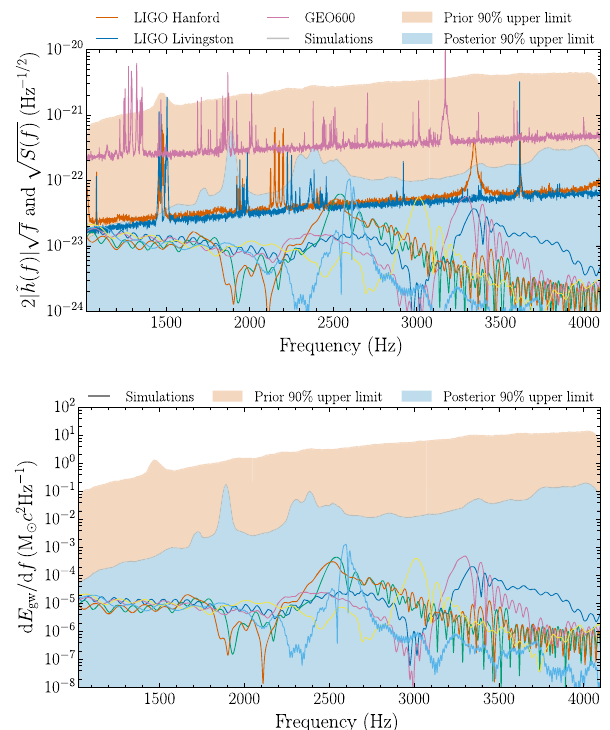
FIG. 13. The 90% credible upper limits on GW strain induced in the Hanford detector (top panel) and radiated energy (bottom panel). Both results are derived from a coherent analysis across the detector network. The noise ASDs for each instrument used in this analysis are shown for comparison top panel). Results from selected numerical simulations are also